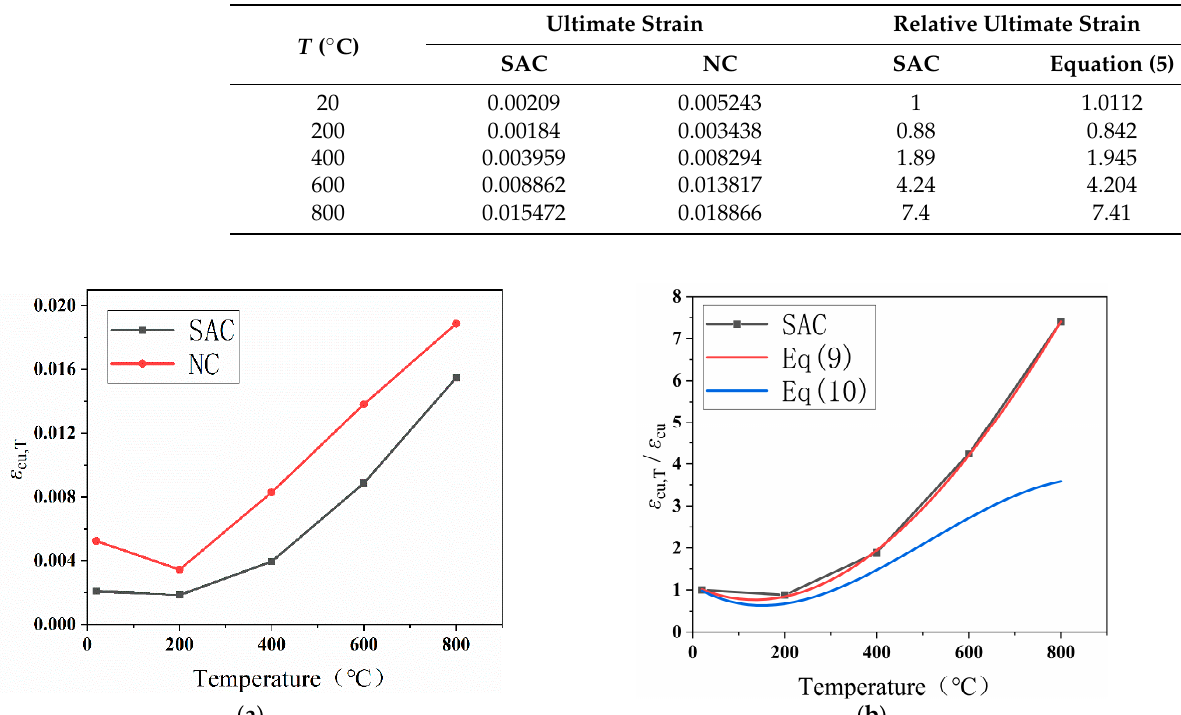
Table 6. Ultimate strain of specimens after high temperature.